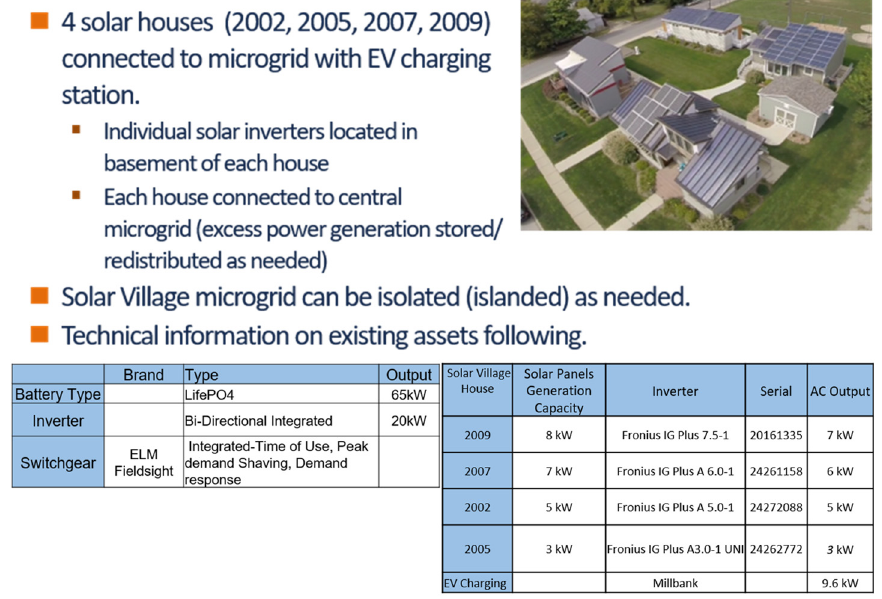
Figure 2. Missouri University of Science and Technology Solar Village Microgrid.